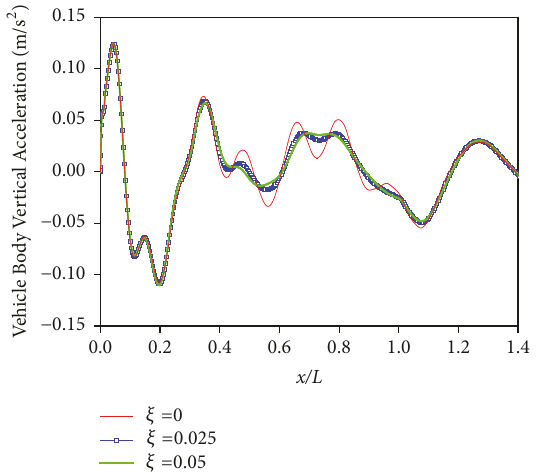
Figure 18: Vertical acceleration of vehicle body with different damping.